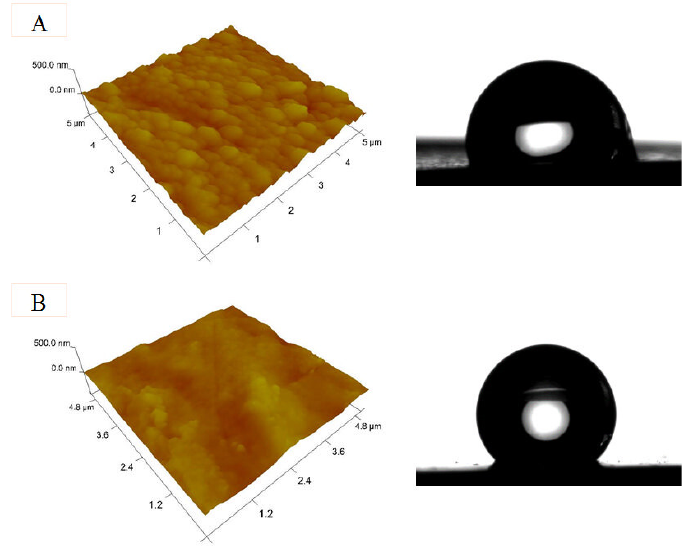
Figure 9. AFM 3D images and photographs of water drops on zinc ( A ) and hybrid zinc ( B ) coatings. Coatings 2022 , 12 , x FOR PEER REVIEW